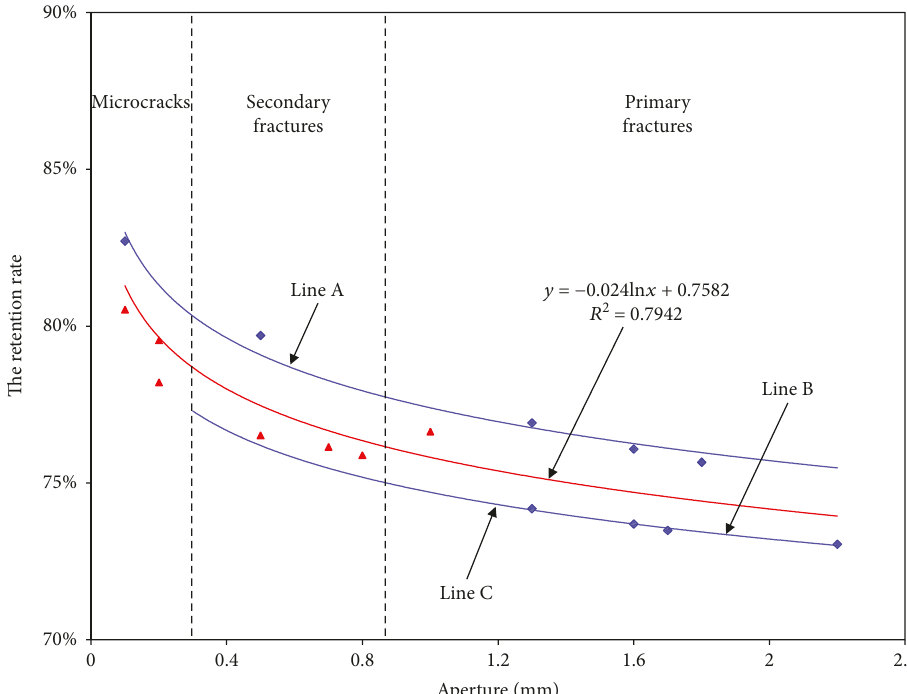
Figure 16: Relationship between the aperture and retention